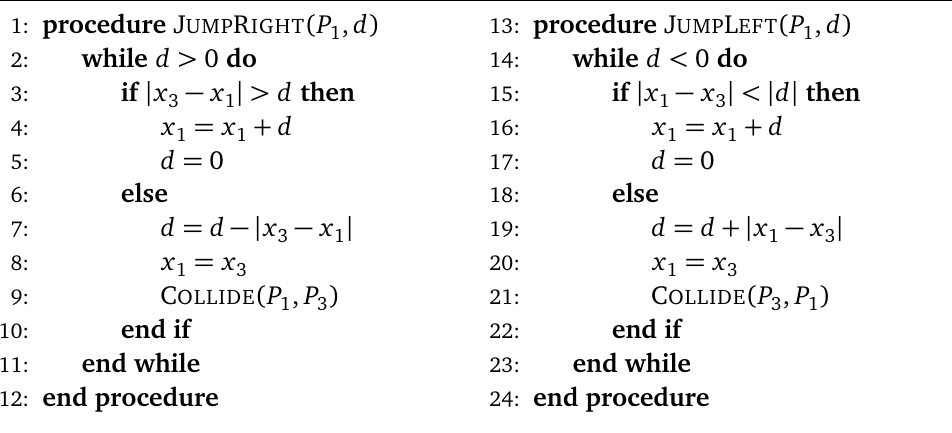
Figure 3: Jump algorithms for the flea gas dynamics. When scattering with each other, particles P and P are instantaneously displaced by a distance d , which de- 1 2 pends on the species and the rapidity of the particles, and it is extracted from the scat- tering matrix of the model (see Eq. (26)). The functions J UMP R IGHT and J UMP L EFT implement this displacement. In J UMP R IGHT and J UMP L EFT particle P is the next 3 particle on the right and on the left of P , respectively. If during the jump P does 1 1 − x | < | d | , then particle not meet particle P , the position of P is shifted by d . If | x 3 1 1 3 P scatters with P . The procedure C OLLIDE is defined in Fig. 1 3